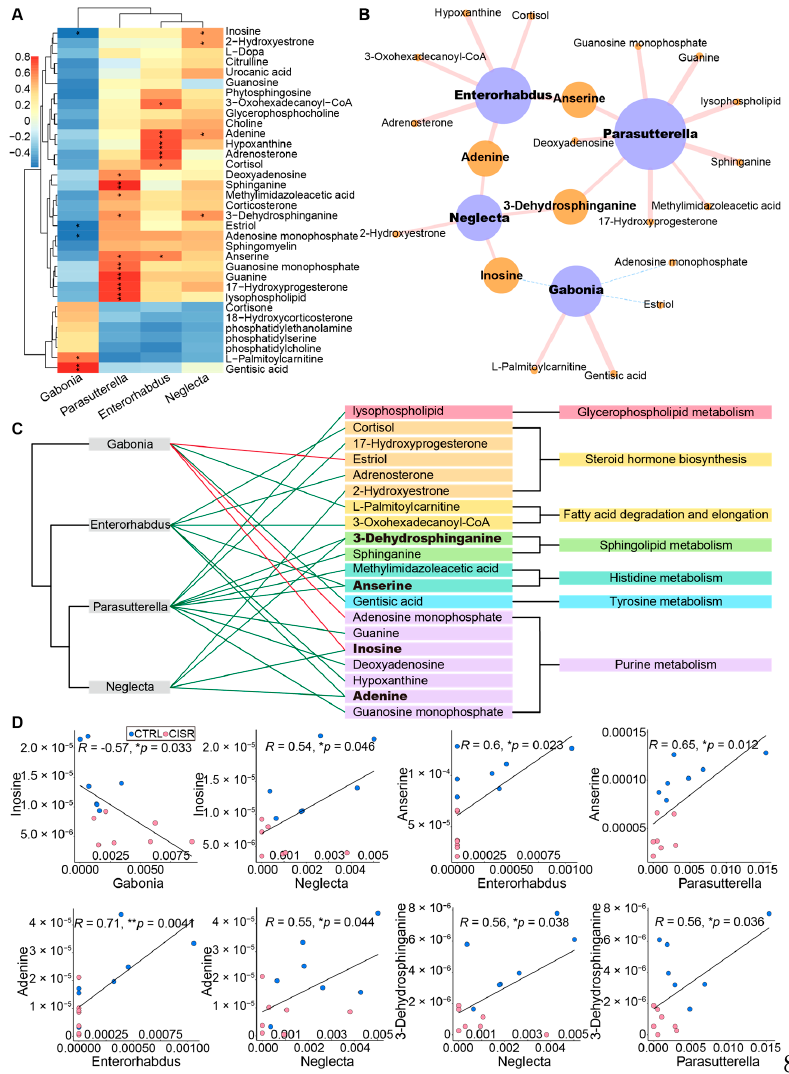
Figure 7. CISR induced metabolic changes correlated with differences in the gut microbiome. ( A ) Correlation plot showed the functional correlation between perturbed gut bacteria and altered fecal metabolites at the genus level. ( B , C ) An integrated correlation-based network analysis (Pear- son’s correlation) of microbes and metabolites. ( B ) The size of the nodes represented the number of significant correlations, and the thickness of lines represented the strength of correlations. The pink solid lines and a blue dotted lines represented positive and negative correlations, respectively. ( C ) The direction of the correlation was indicated by green (positive) or red (negative) lines, and bold indicates metabolites with greater correlativity. ( D ) Scatter plots illustrate associations between altered gut bacteria genera and typical gut microflora-related metabolites, including glycerophospholipids, fatty acids, amino acids, and purines (* p < 0.05; ** p < 0.01, Pearson’s